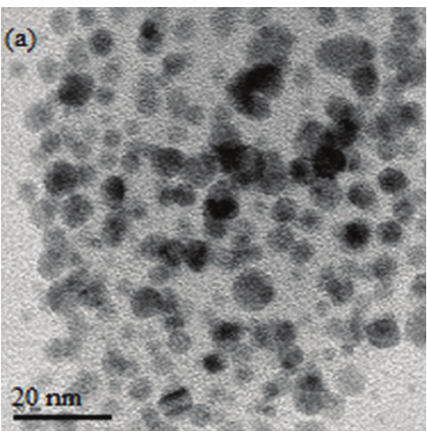
Figure6:TEMimageofchitosan-Agnanoparticlematerialssynthe- sized with 0.06 M AgNO 3 .